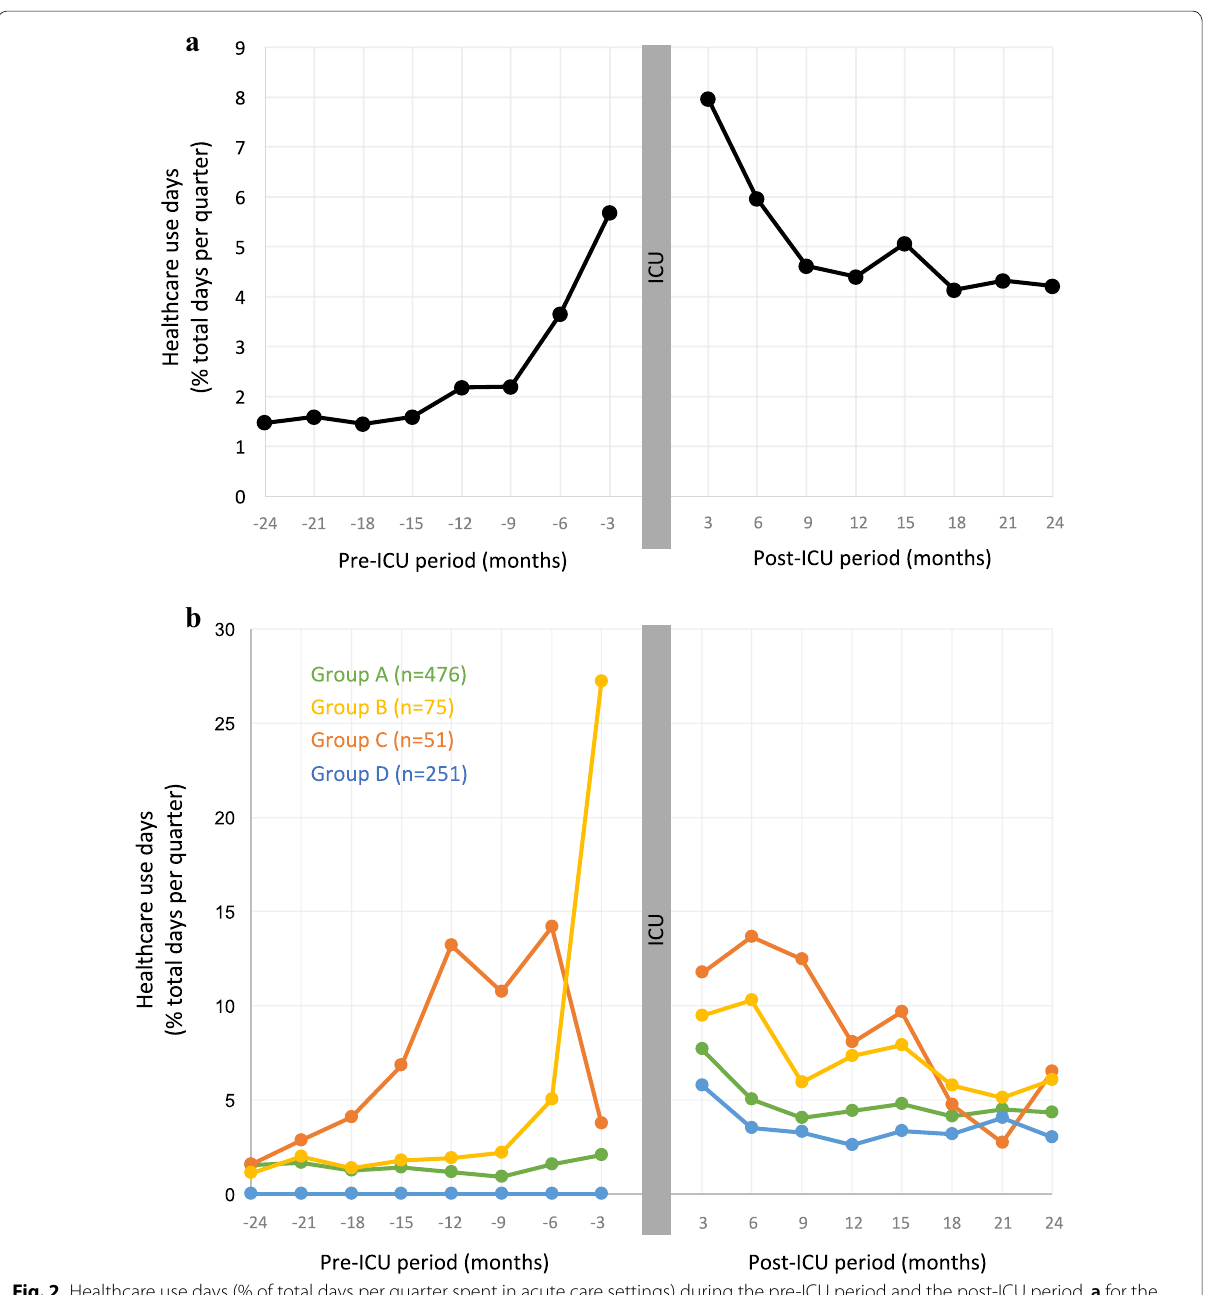
Fig. 2 Healthcare use days (% of total days per quarter spent in acute care settings) during the pre‑ICU period and the post‑ICU period, a for the whole population, and b after clustering based on total pre‑ICU healthcare use (see text fort details regarding clustering